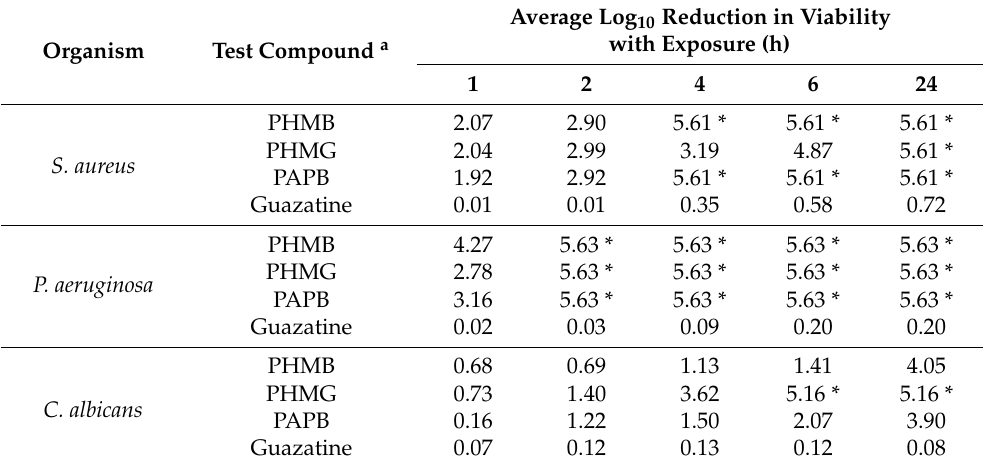
Figure 4. The antimicrobial activity of PHMB, PHMG, PAPB, and guazatine against A. castellanii (ATCC 50370) cysts over a 24 h period at a concentration of 7.8 µ g/mL. Error bars show the standard error of the mean (SEM) from triplicate experiments. Table 3. Efficacy of PHMB, PHMG, PAPB, and guazatine acetate against S. aureus , P. aeruginosa, and C. albicans over a 24 h period formulated in contact lens base